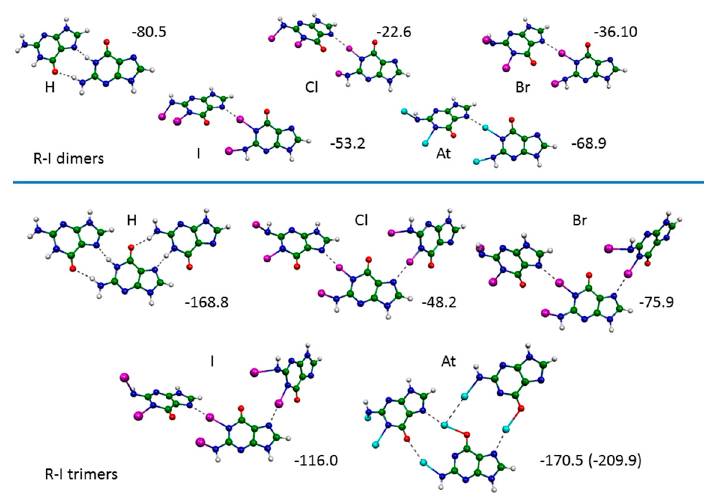
Figure 2. Optimised structures of the 1,2X-G ••• 1,2X-G R-I dimers and trimers (X = H, Cl, Br, I, At), with their interaction energies (in kJ / mol). The interaction energy in brackets for the At-substituted trimer is calculated with respect to two 1,6At-G monomers and one 1,2At-G monomer.